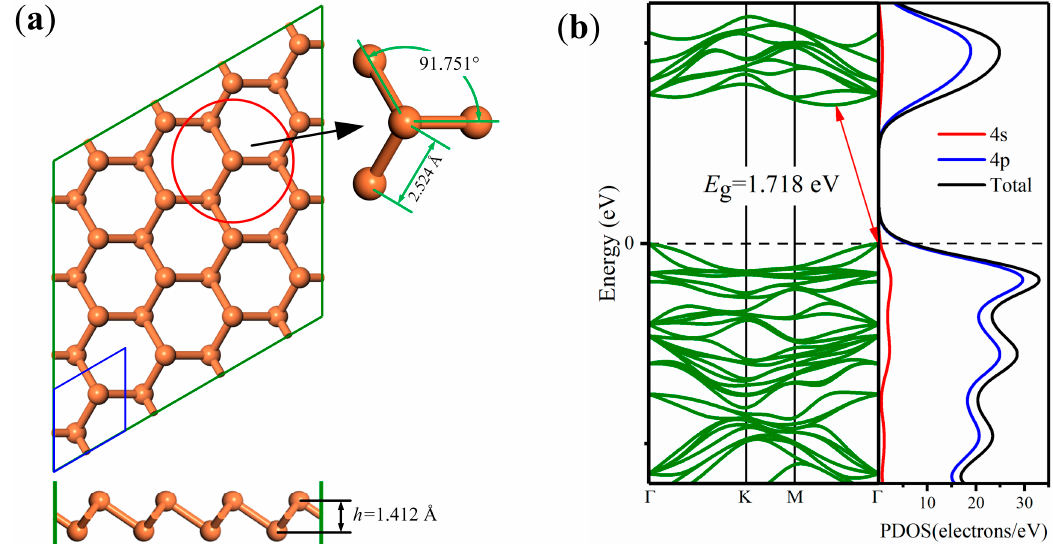
Figure 2. ( a ) Optimized structure of monolayer arsenene. The blue and green boxes in the top view (top panel) show the primitive cell and the 4 × 4 supercell, respectively. The buckling height ( h ) is indicated in the side view (bottom panel). ( b ) Electronic band structure (left panel) and partial density of states (PDOS) (right panel) of the 4 × 4 supercell of monolayer arsenene. The Fermi energy was set to zero.